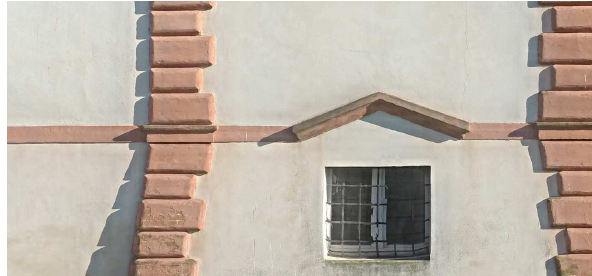
Figure 34: a detail of the orthophoto in fig. 33 Figure 29: detail of the cloud obtained from the integrated model (medium quality) In conclusion, the potential offered by RPAS photogrammetric low-cost and user friendly systems, are very interesting and they will see a growing trend in the world of the cultural heritage survey. However in order to achieve an adequate level of precision is required compliance with some simple rules that were in part highlighted in this